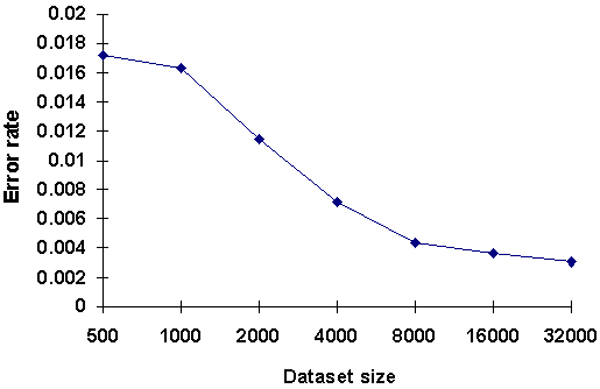
The impact of dataset size on error rate of PDF of FM d-value. We show the error rate for different data sizes from 500 to 32000. For each data size, we generated 10 datasets, and thus derived 10 probability density functions. The maximum standard deviation for all d-values is recorded as the error rate for that data size. The error rate decreases as the size of the dataset increases.